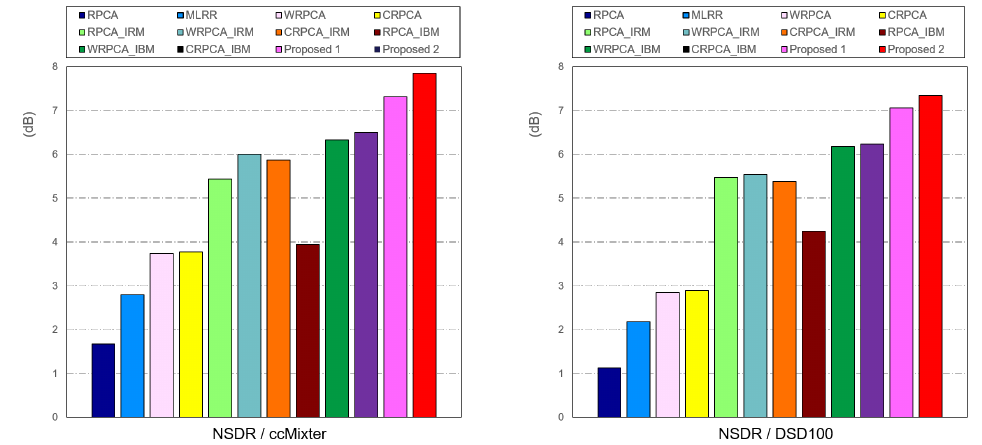
Figure 8. Comparison of SVS between ccMixter and DSD100 datasets for each of the following: RPCA, MLRR, WRPCA, CRPCA, RPCA using IRM, WRPCA using IRM, WRPCA using IRM, RPCA using IBM, WRPCA using IBM, CRPCA using IBM, Proposed 1, and Proposed 2,